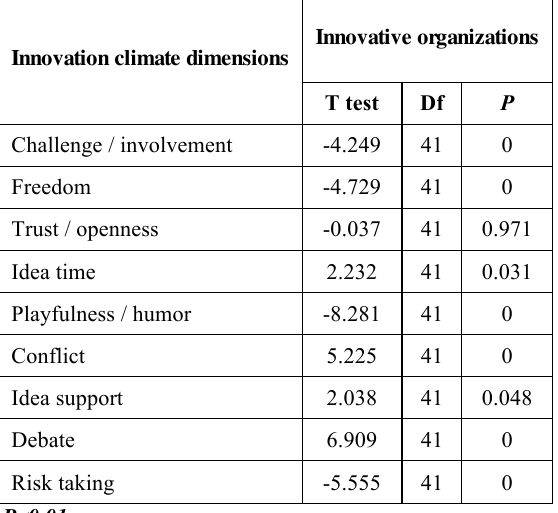
Table 6. T-test values of comparing means of innovation climate dimensions between the company and the innovative